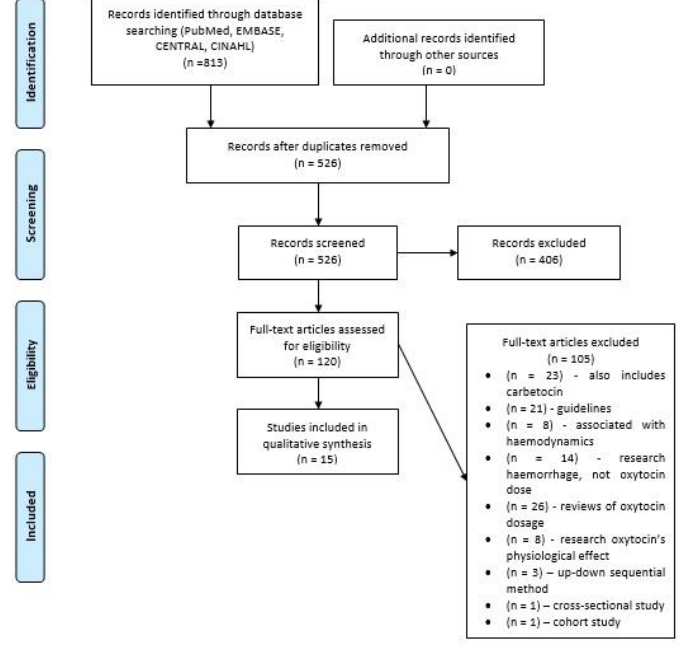
Figure 1. Flow chart